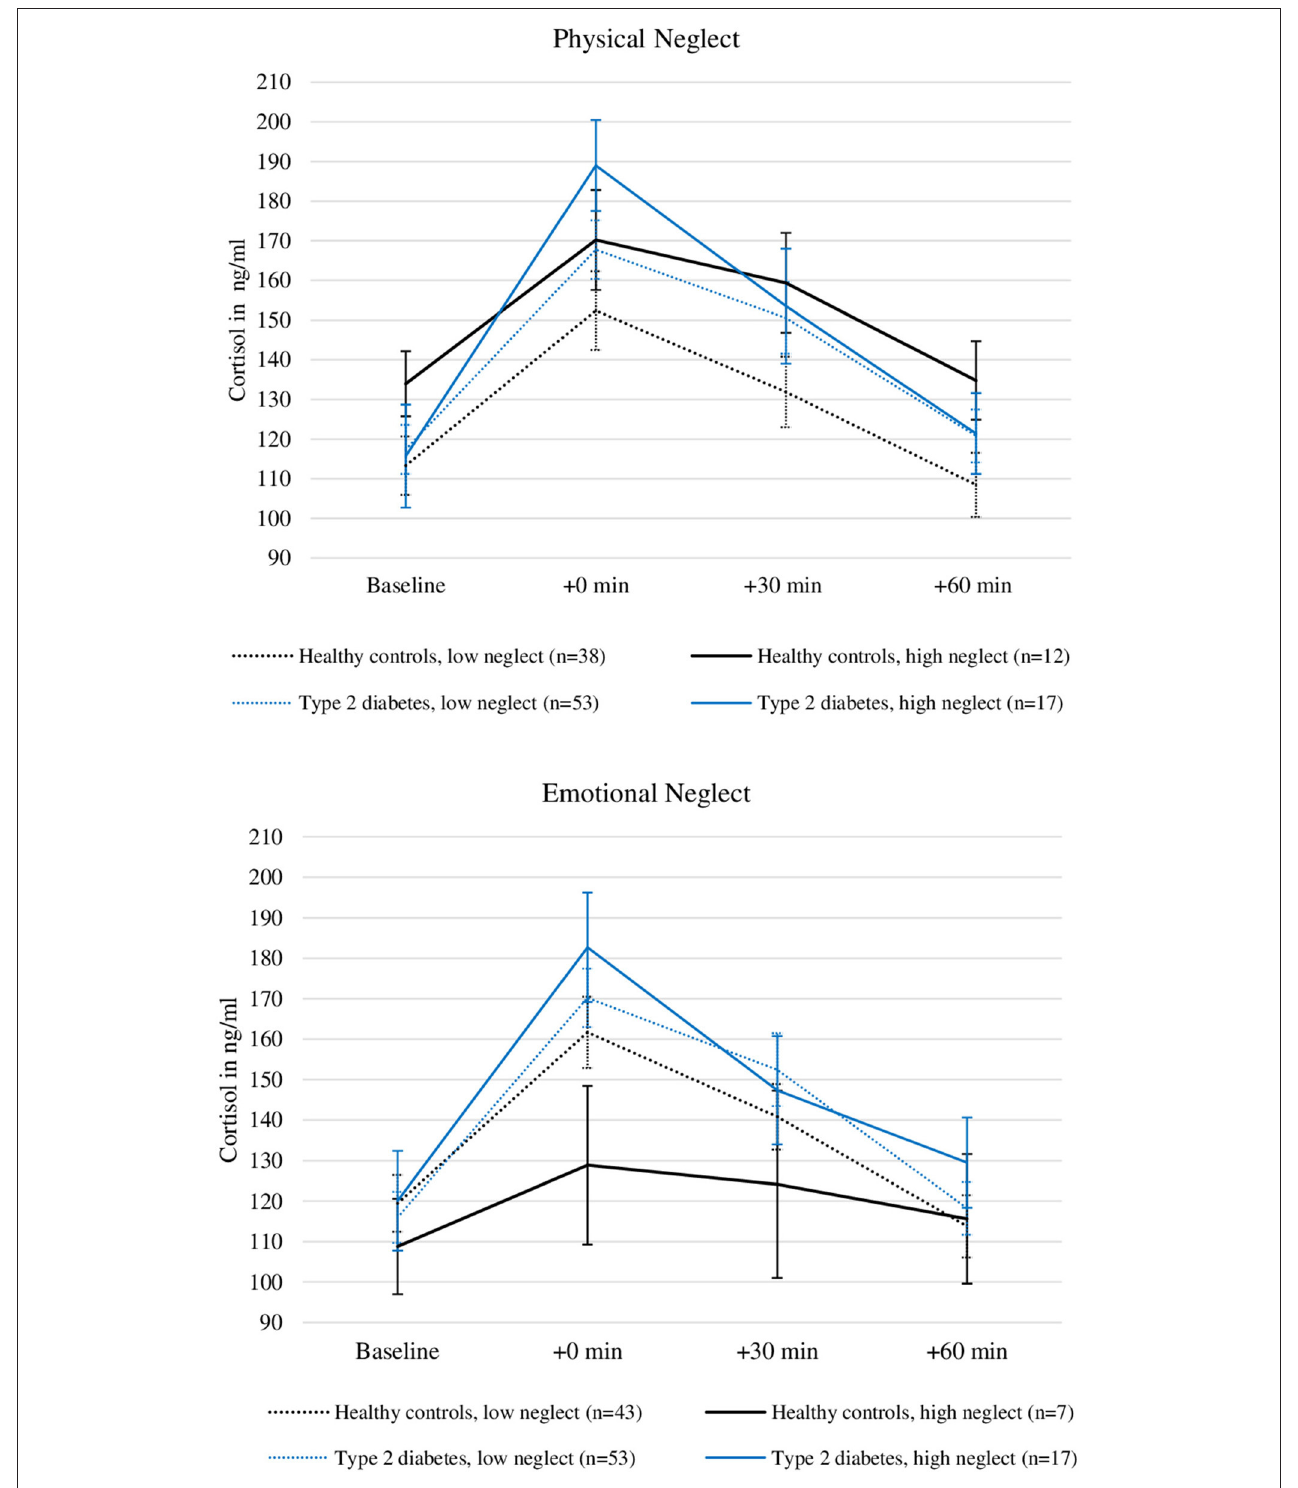
FIGURE 3 | Plasma Cortisol levels before and after stress induction in patients with type 2 diabetes and healthy controls with and without the experience of “moderate to severe” childhood physical and emotional neglect. Depicted are average values and standard errors. Grouping the sample according to reports of moderate to severe neglect was done solely for the purpose of the visualization. Group differences were not tested in this study. Details on the descriptive values displayed in the figure can be found in the Supplementary Material .